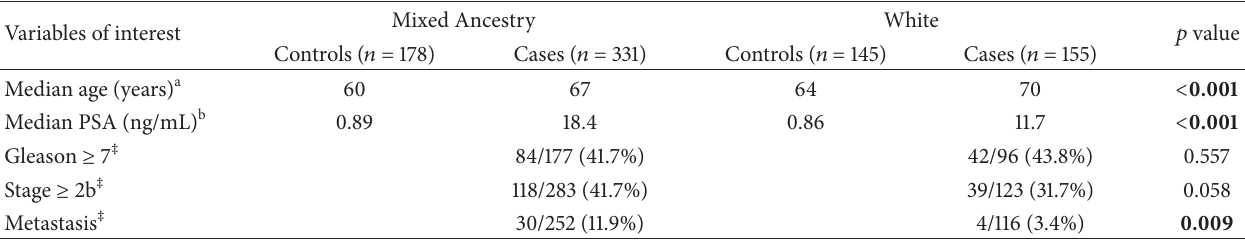
Table 1: Clinical characteristics among South African cases and